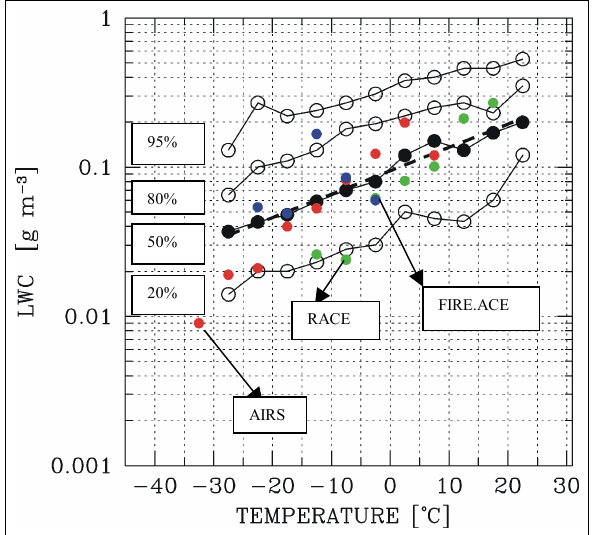
Fig. 3. Median values of LWC compared with the results of GI. The black circles are for median values of LWC from Gultepe and Isaac (1997). The dashed line is a fit to the median values of GI.